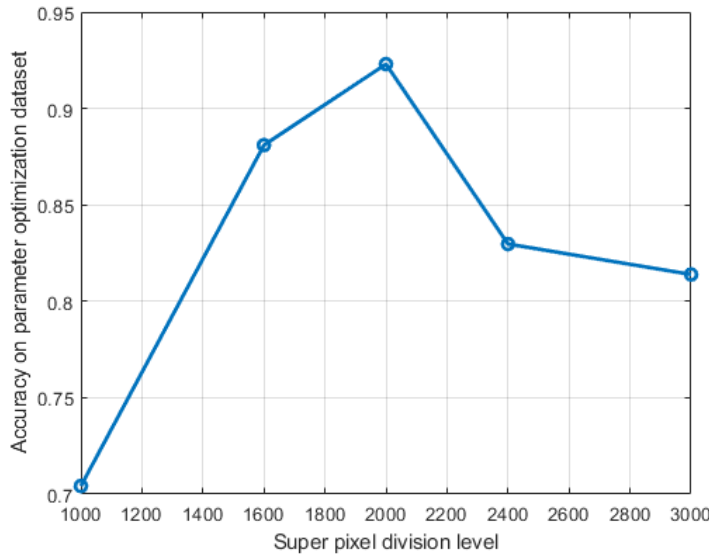
Figure 3. Performance of different super pixel classification levels on parameter optimization